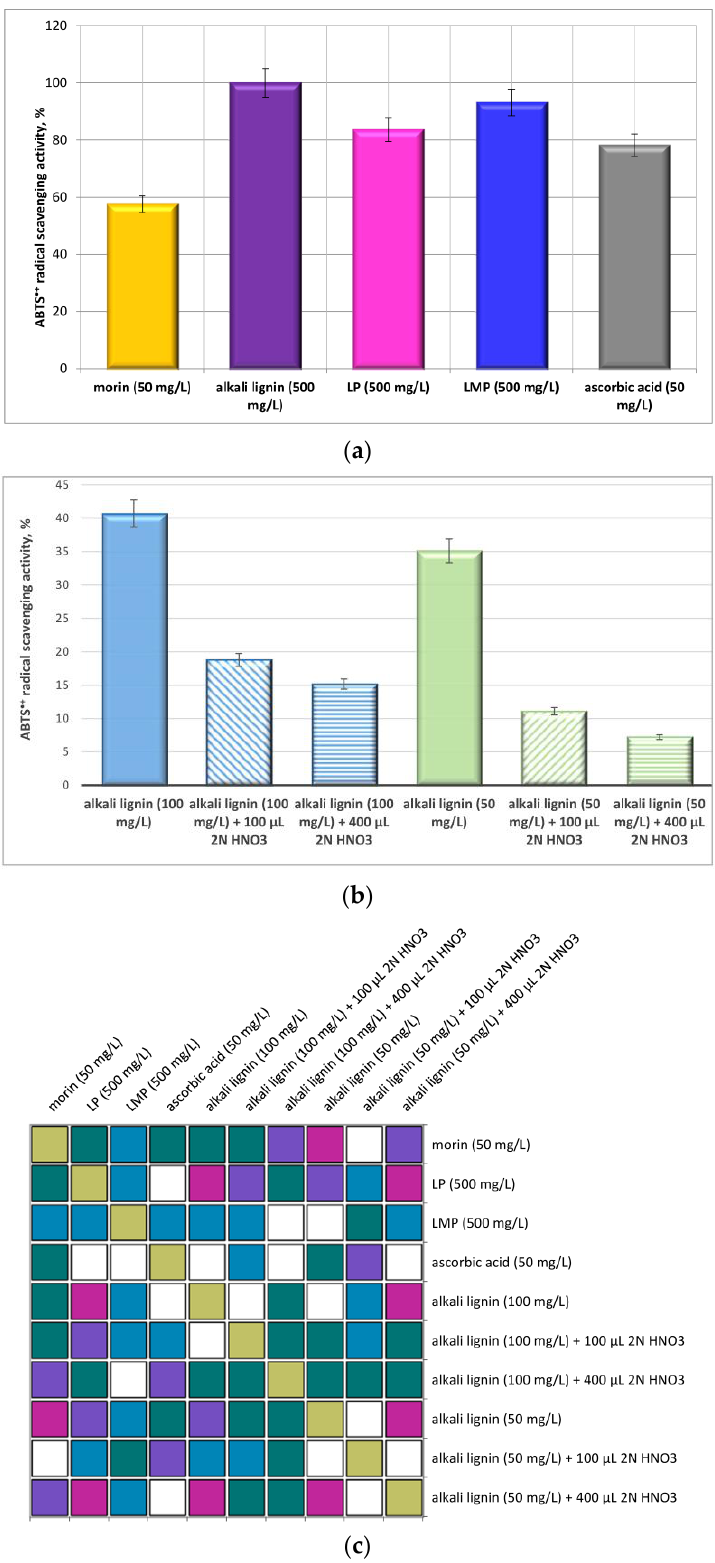
Figure 8. ABTS radical - scavenging activity, % (±SD). ( a ) ABTS activity of LPs, LMPs and pure sub- stances. ( b ) Effect of nitric acid on the DPPH activity of alkali lignin. ( c ) p - values map: yellow— p = 0; purple— p < 0.05; violet— p < 0.08; turquoise— p < 0.15; blue— p < 0.3; white— p < 0.5.